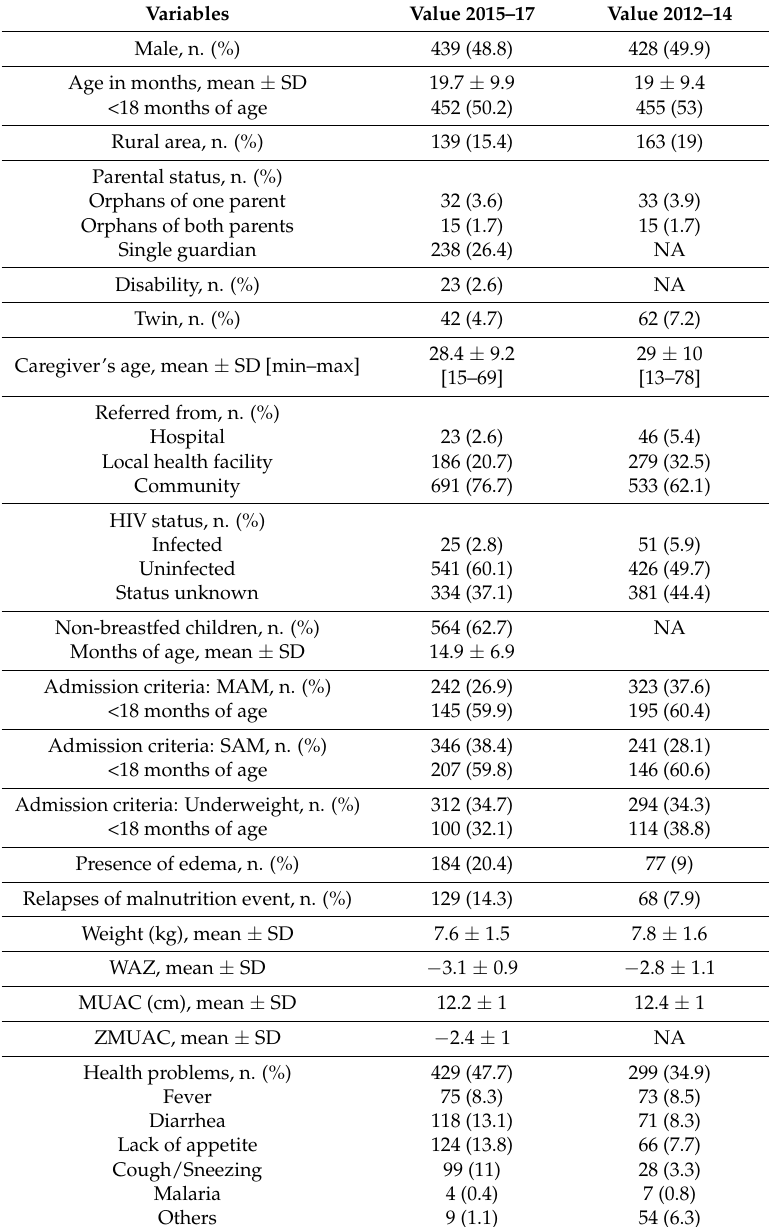
Variables Value 2015–17 Value 2012–14 Male, n.